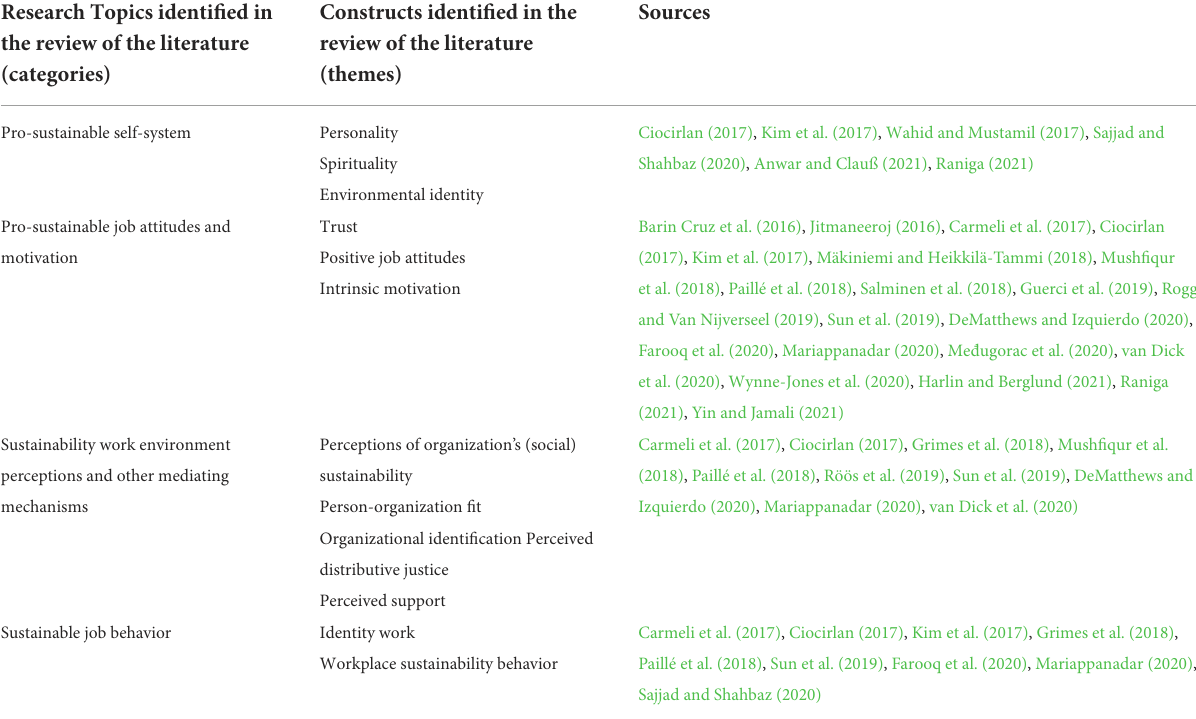
TABLE 3 People-focused Research Topics and